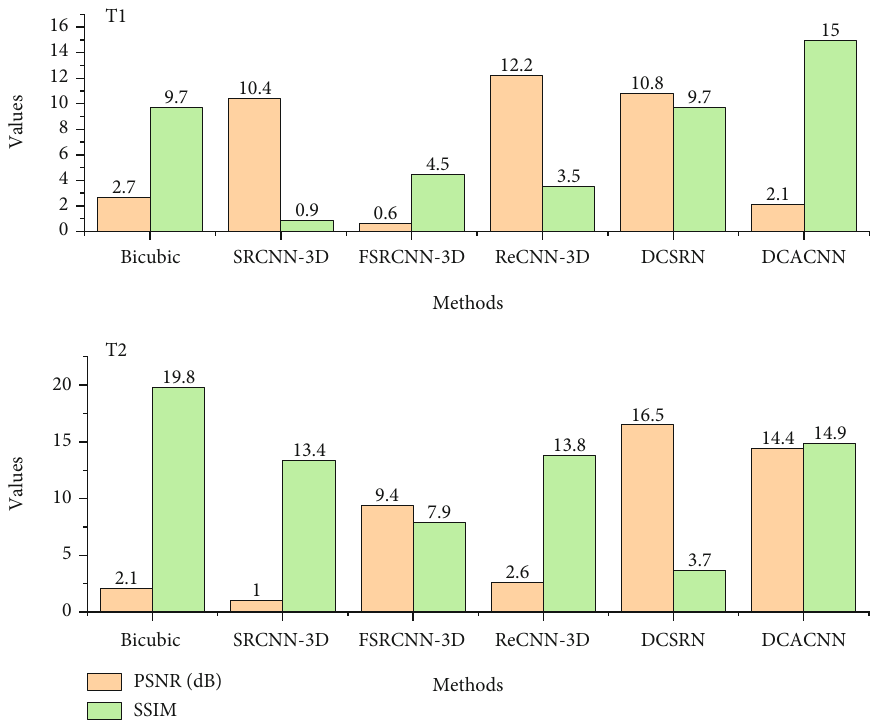
Figure 5: Test results of the algorithm on T1- and T2-weighted